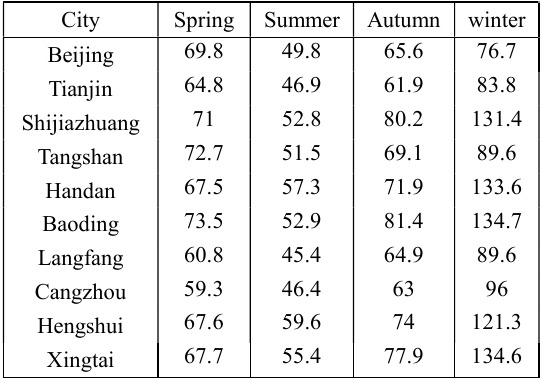
Figure 4. Seasonal PM2.5 concentration in “2+26”